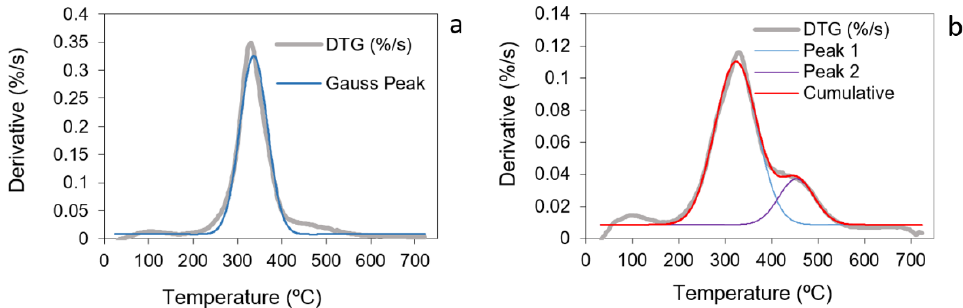
Figure 7. DTG profiles derived from thermal analysis under inert conditions for the ( a ) fresh and ( b ) digested sample after a six-month stabilization period.